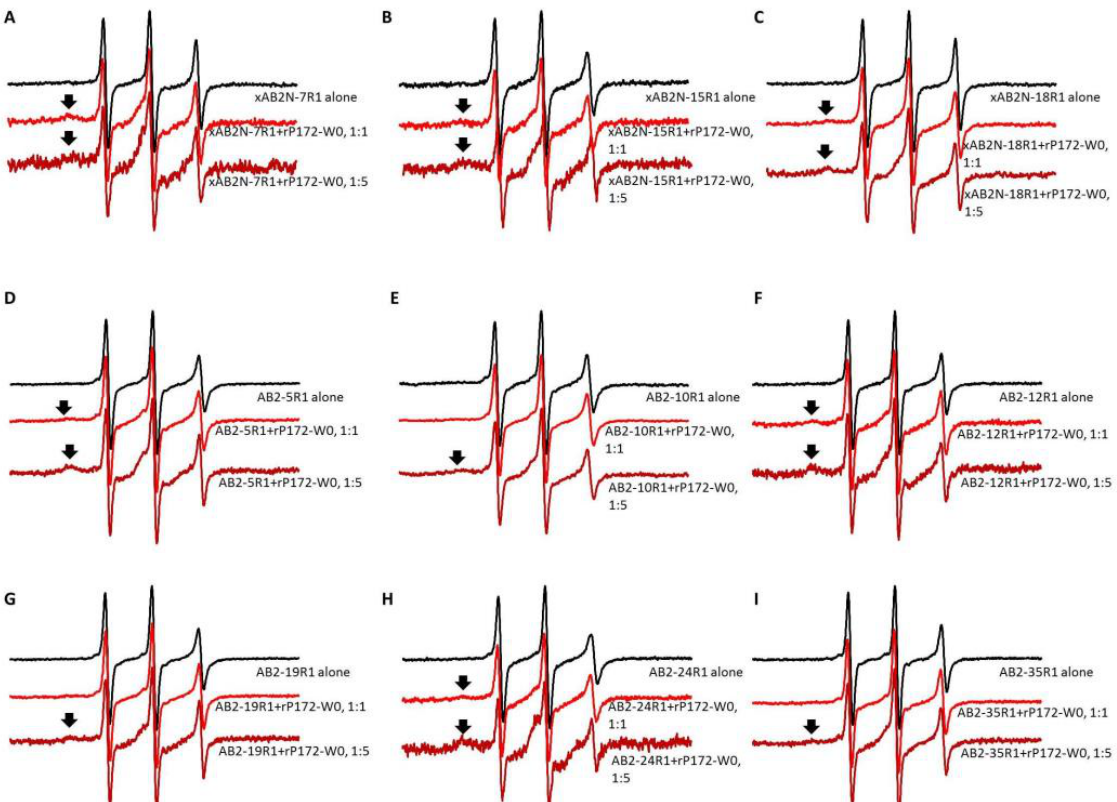
Figure 3. Representative EPR spectra of 15 µ M peptide with rP172-W0 at indicated peptide-to-protein molar ratios. Arrows denote immobile spectral components. xAB2N spin-labeled at positions ( A ) 7, ( B ) 15, and ( C ) 18 and AB2 spin-labeled at positions ( D ) 5, ( E ) 10, ( F ) 12, ( G ) 19, ( H ) 24, and ( I ) 35.